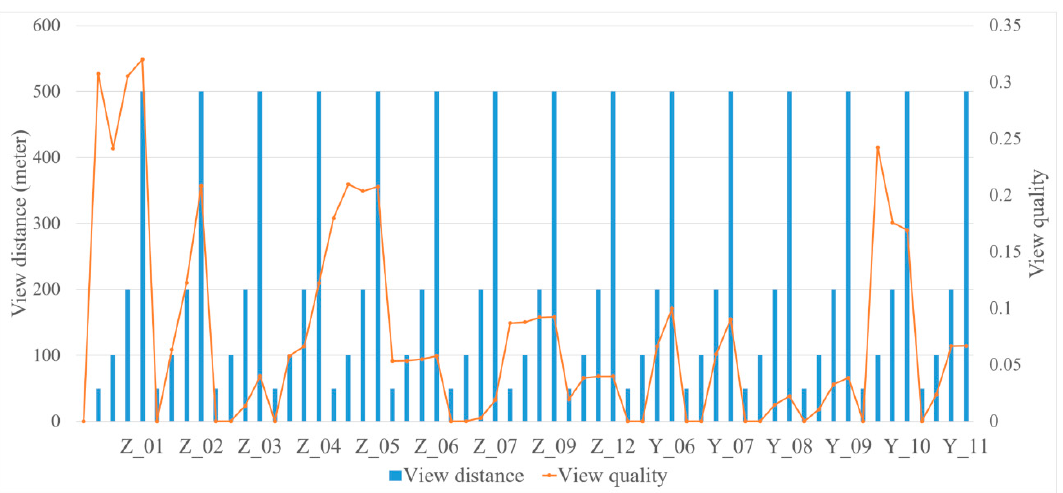
Figure 6. Diagram of view quality.